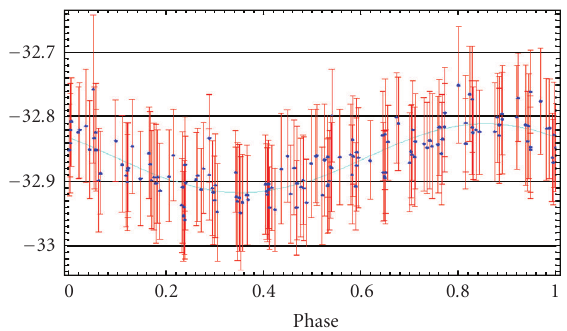
Figure 12: The planet of 51 Pegasi with STELLA-I/SES. The orbital period of the planet is 4.23 days ( e = 0; continuous line) and the velocity amplitude is ≈ 100 m/s. Our overall rms of the data is 30m/s, an individual measurement error is ≈ 70 m/s. The data span between May and August in 2008 and are plotted directly from the SES pipeline. Note that no other measures than the thermal and mechanical stabilization of the spectrograph were